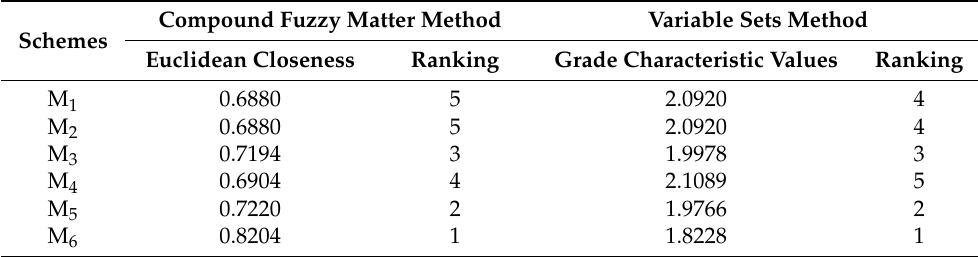
Table 6. Comparison with the results of the fuzzy matter element